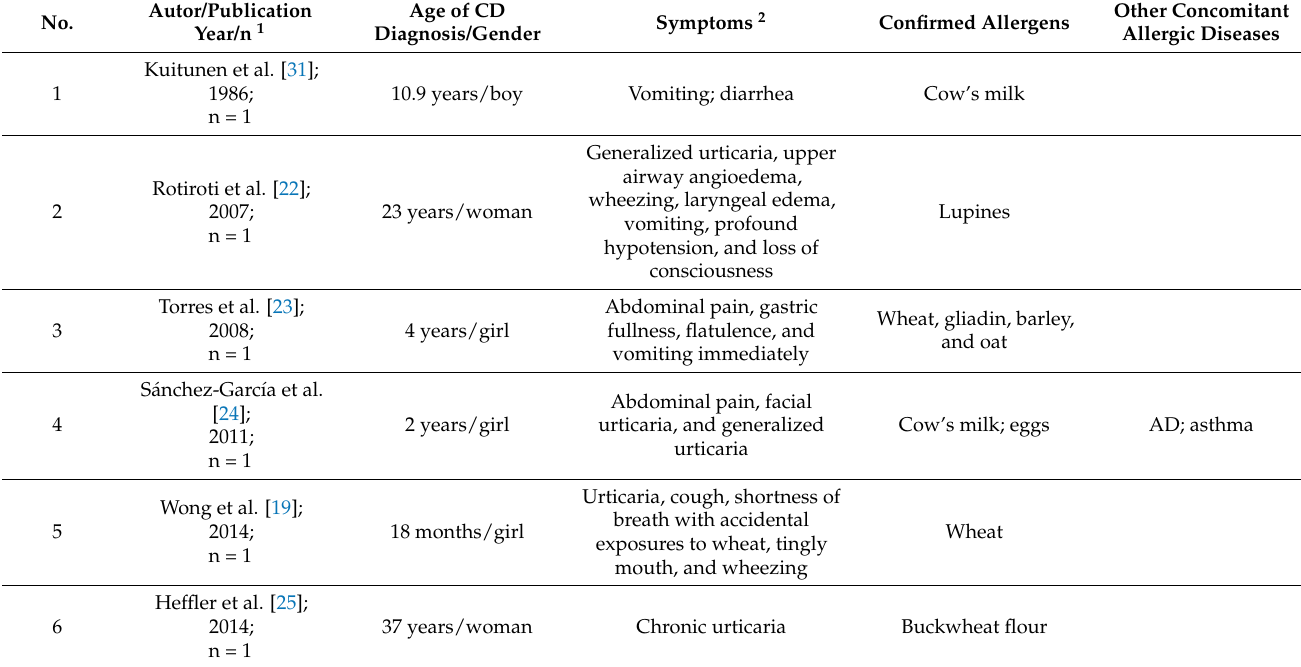
Table 3. Comparison of case reports of IgE-mediated allergies in subjects with CD included in the literature